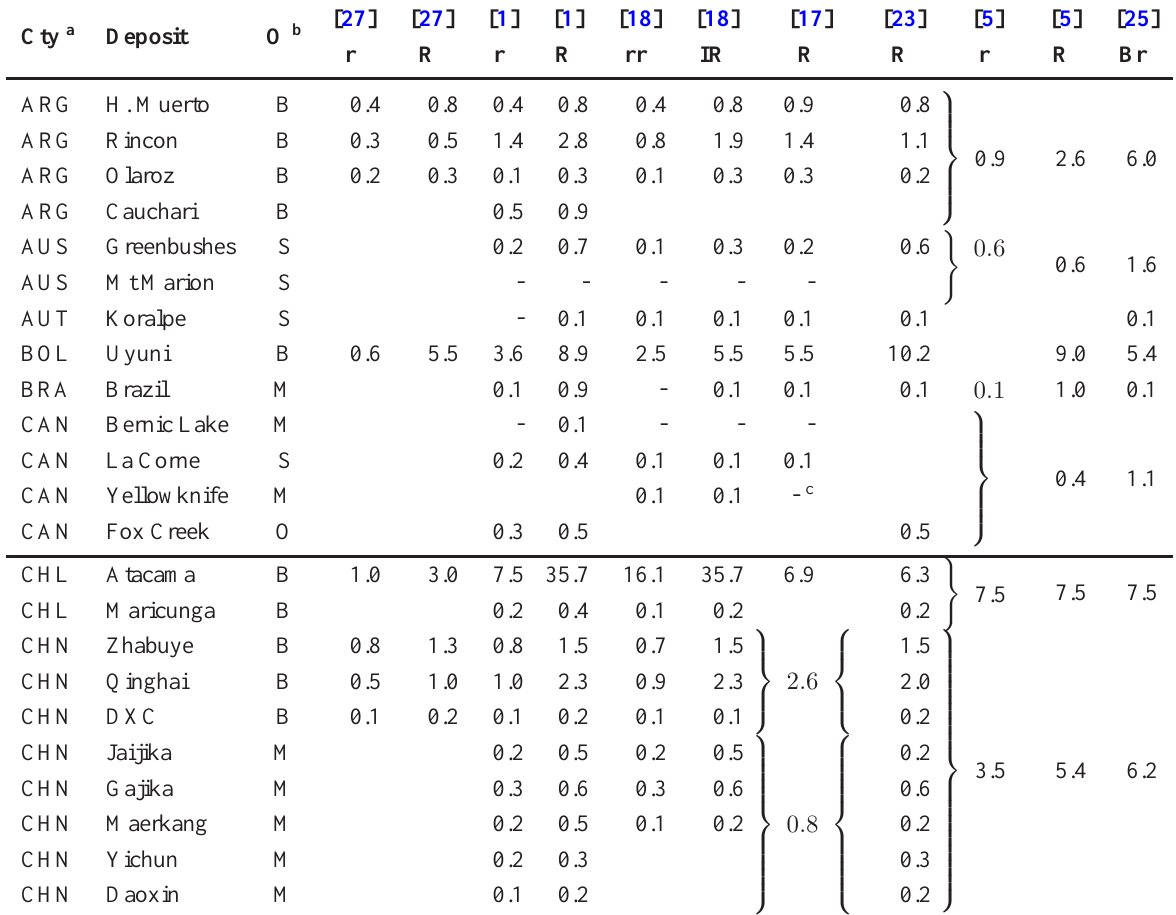
Table 3. Lithium literature summary (Mt